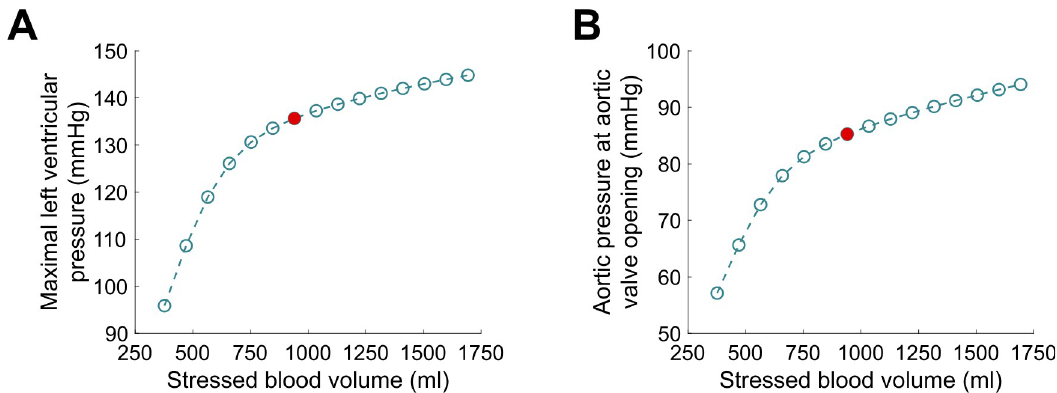
Fig 11. A. Maximal left ventricular pressure during vascular filling simulations. B. Aortic pressure at valve opening during vascular filling simulations. The latter is used to quantify the afterload.